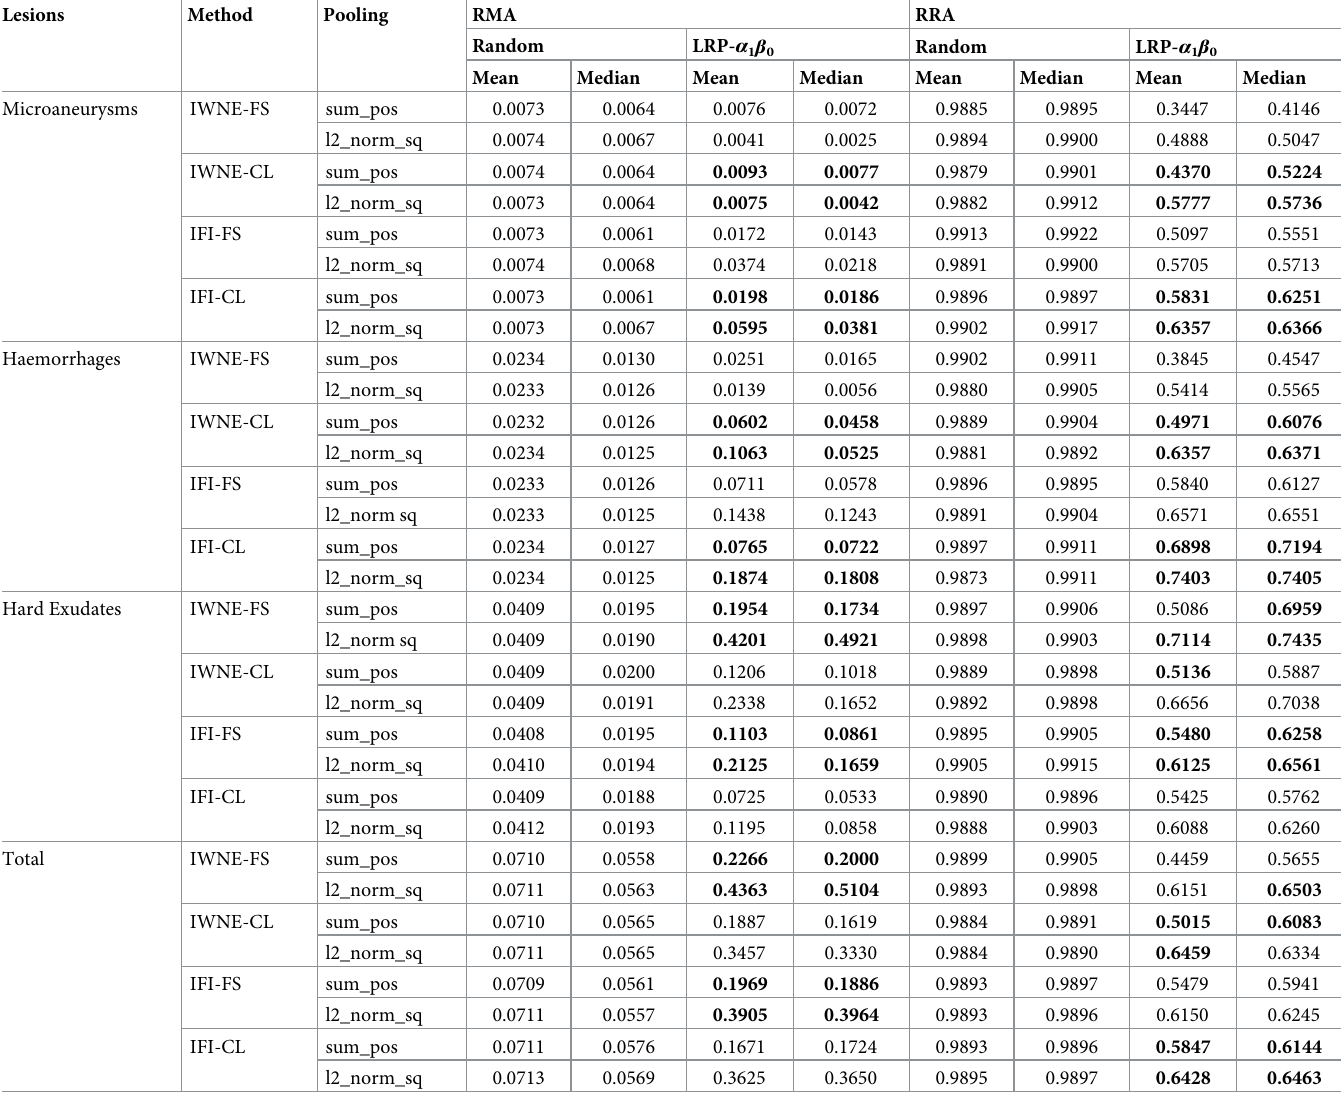
Table 3. Relevance mass accuracy (RMA) and relevance rank accuracy (RRA) on the LRP- α 1 β 0 explanation heatmaps of images of the IDRiD dataset. The results show that while supervised models overfit on the hard exudates, the self-supervised models look at diverse set of input features (lesions). On the other hand, we also find that IFI models show higher accuracies when compared to IWNE